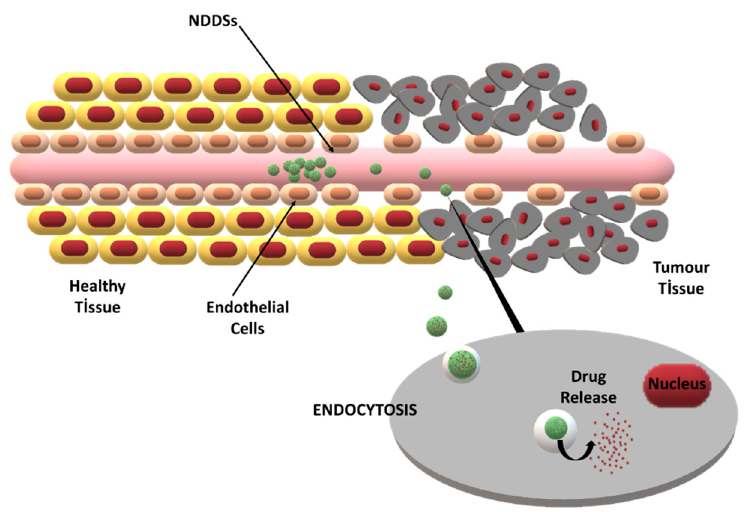
Figure 2. The enhanced permeability and retention (EPR) effect and its role in passive drug target- ing to tumor cells via